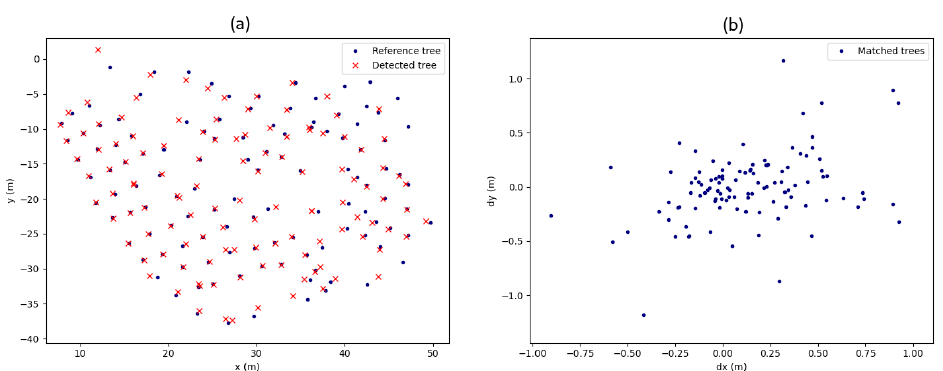
Figure 16. ( a ) A comparison between each subtracted tree and its reference tree. ( b ) Positional accuracy plots.